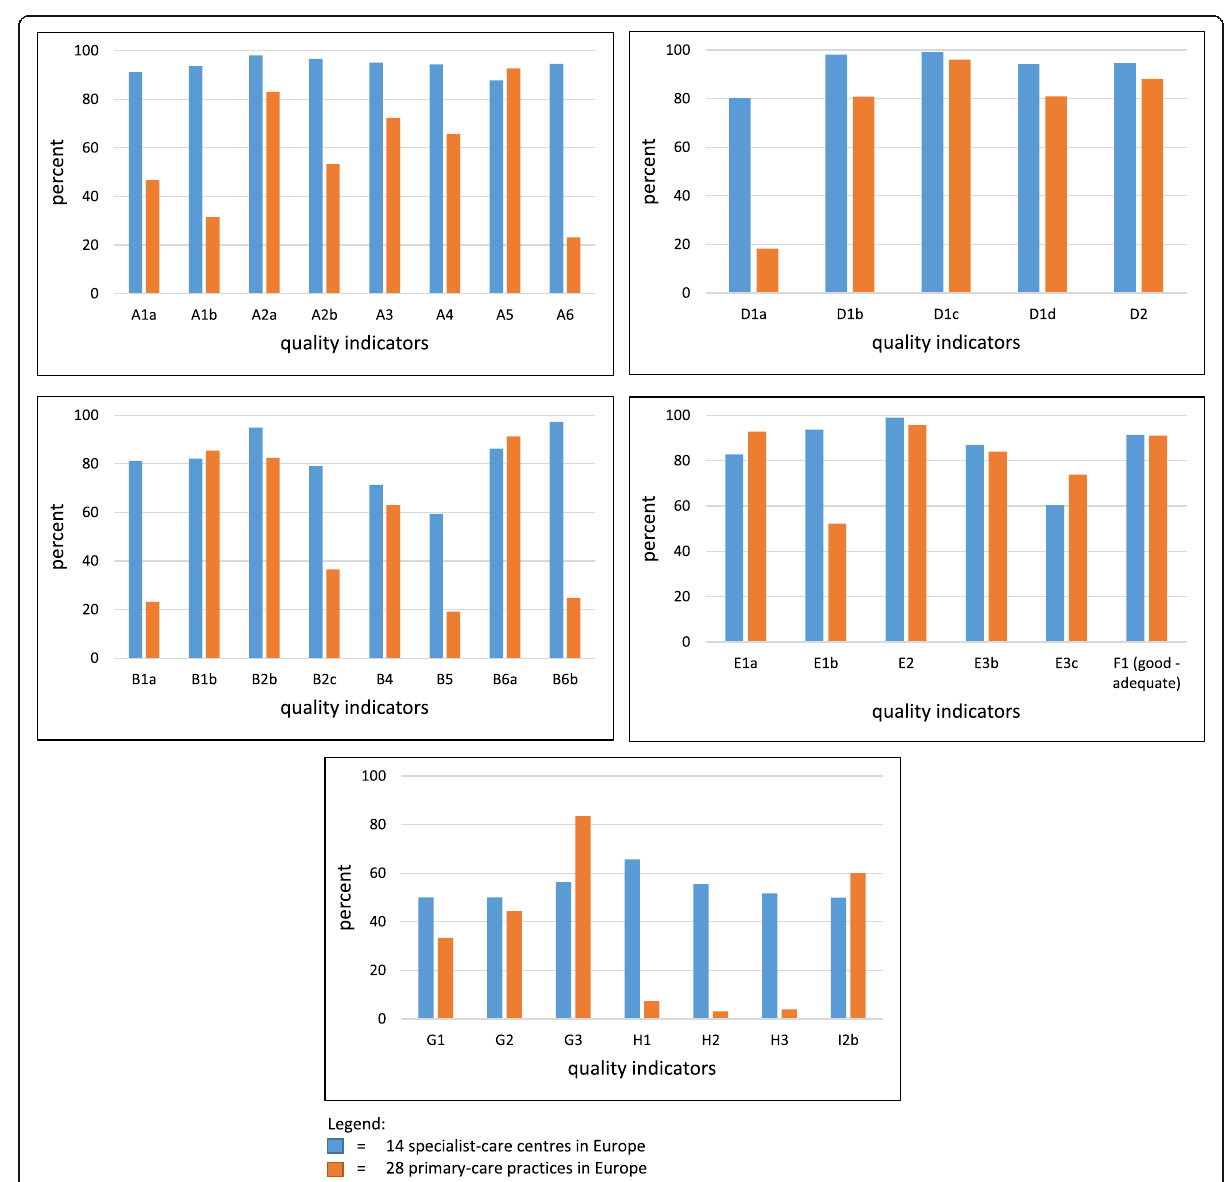
Fig. 3 Headache service quality evaluation: comparisons between specialist and primary care in Europe in eight quality domains. A: accurate diagnosis; B: individualized management; D: education of patients; E: convenience and comfort; F: patients ’ satisfaction; G: efficiency and equitability; H: outcome